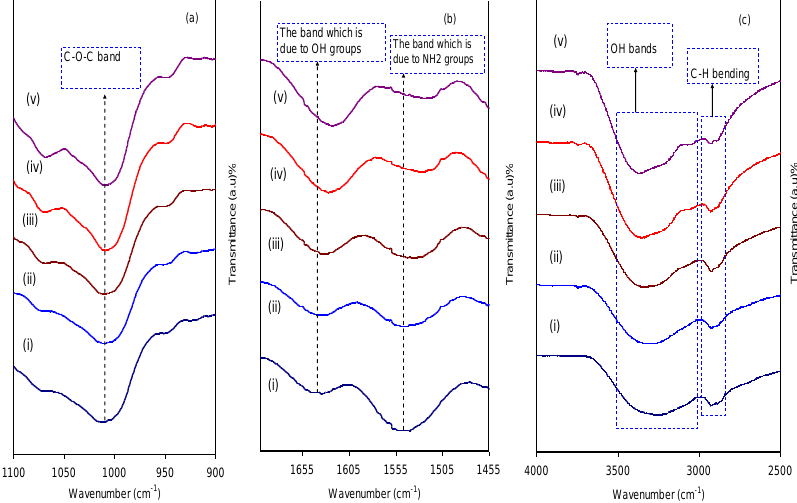
Figure 4. Spectra of FTIR for (i) CSDPE0, (ii) CSDPE1, (iii) CSDPE2, (iv) CSDPE3, and (v) CSDPE4 in the range ( a ) 900 to 1100 cm⁻ 1 , ( b ) 1455 to 1700 cm⁻ 1 , and ( c ) 2500 to 4000 cm⁻ 1 .